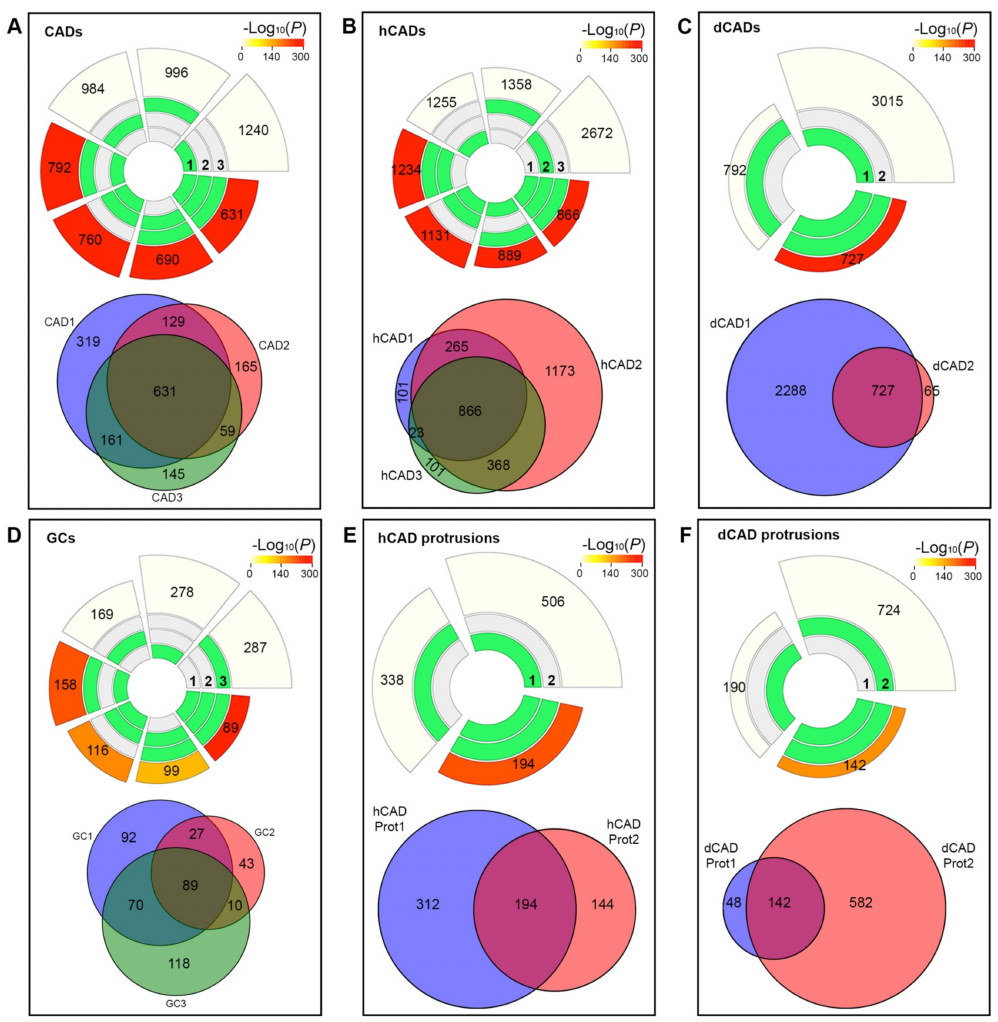
Figure 3. Reproducibility of LCM/MS Microproteomic data. Data were normalized for protein length using NSAF, differential expression between samples (DESeq), transformed to obtained normal data using Johnson transformations. Circular plots (top), obtained using SuperExactTest, show the intersections and the corresponding statistics of the significant proteins identified by MS from ( A ) CADs, ( B ) hCADs, ( C ) dCADs, ( D ) GCs, ( E ) hCAD protrusions, or ( F ) dCAD protrusions. The tracks in the middle represent each protein set from individual replicate (1–3) and the green and white blocks show the “presence” or “absence”, respectively, of the proteins in each intersection. In the outer layer, the height of the bars is proportional to the intersection sizes and the number of proteins is indicated on the top of the bars. The color intensity of the bars is a representation of the significance of the intersections ( − log 10 ( P )). Highly significant intersections were observed for controls and protrusions, demonstrating that the small sample size of the protrusions doesn’t affect the accuracy of protein identification. Venn diagrams (bottom) of protein hits identified for all samples ( A – F ) show a strong protein overlap for all samples, further demonstrating that data analysis are not affected by sample size and that microproteomics data from LCM/MS are